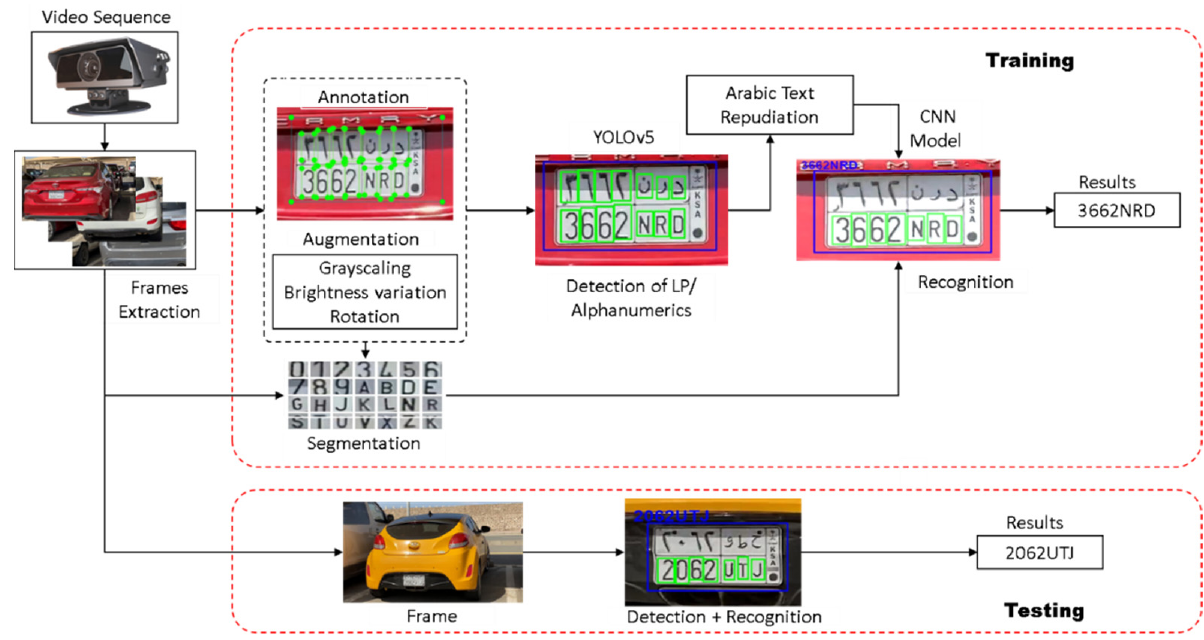
Figure 1. Pipeline for CNN-based ALPR system.